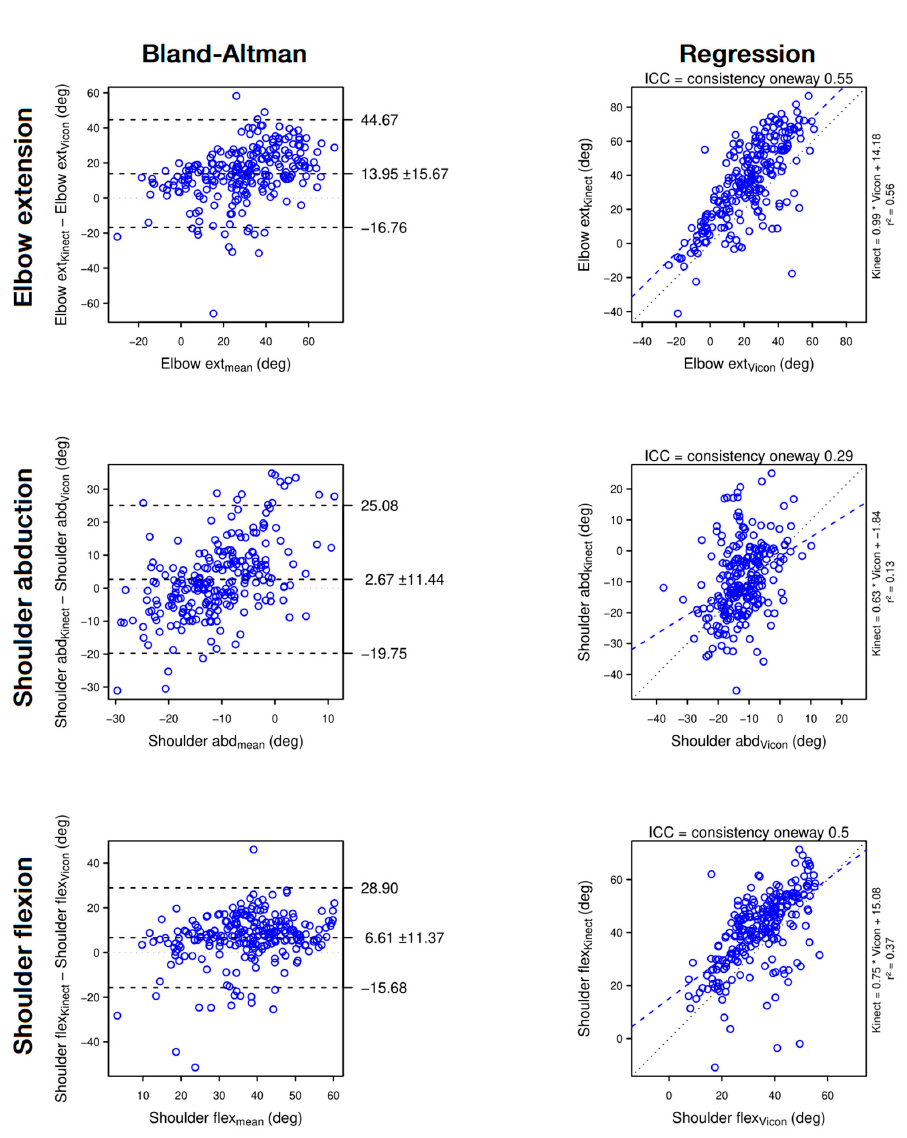
Figure 3. Bland–Altman plots ( left panels ) and regression plots ( right panels ) of elbow extension (1st row), shoulder abduction (2nd row) and shoulder flexion (3rd row). The Bland–Altman plots show that the Kinect strongly overestimates elbow extension, and slightly overestimates shoulder abduction and shoulder flexion. The regression plots show that, when assessed with the Kinect, elbow extension and shoulder flexion are moderately reliable and shoulder abduction is poorly reliable.